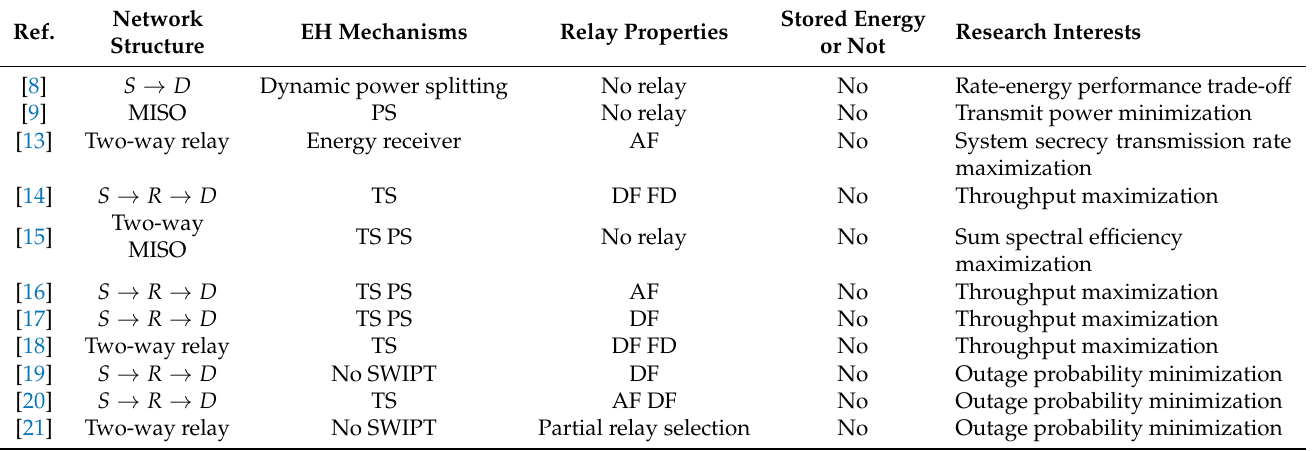
Table 1. Review of related